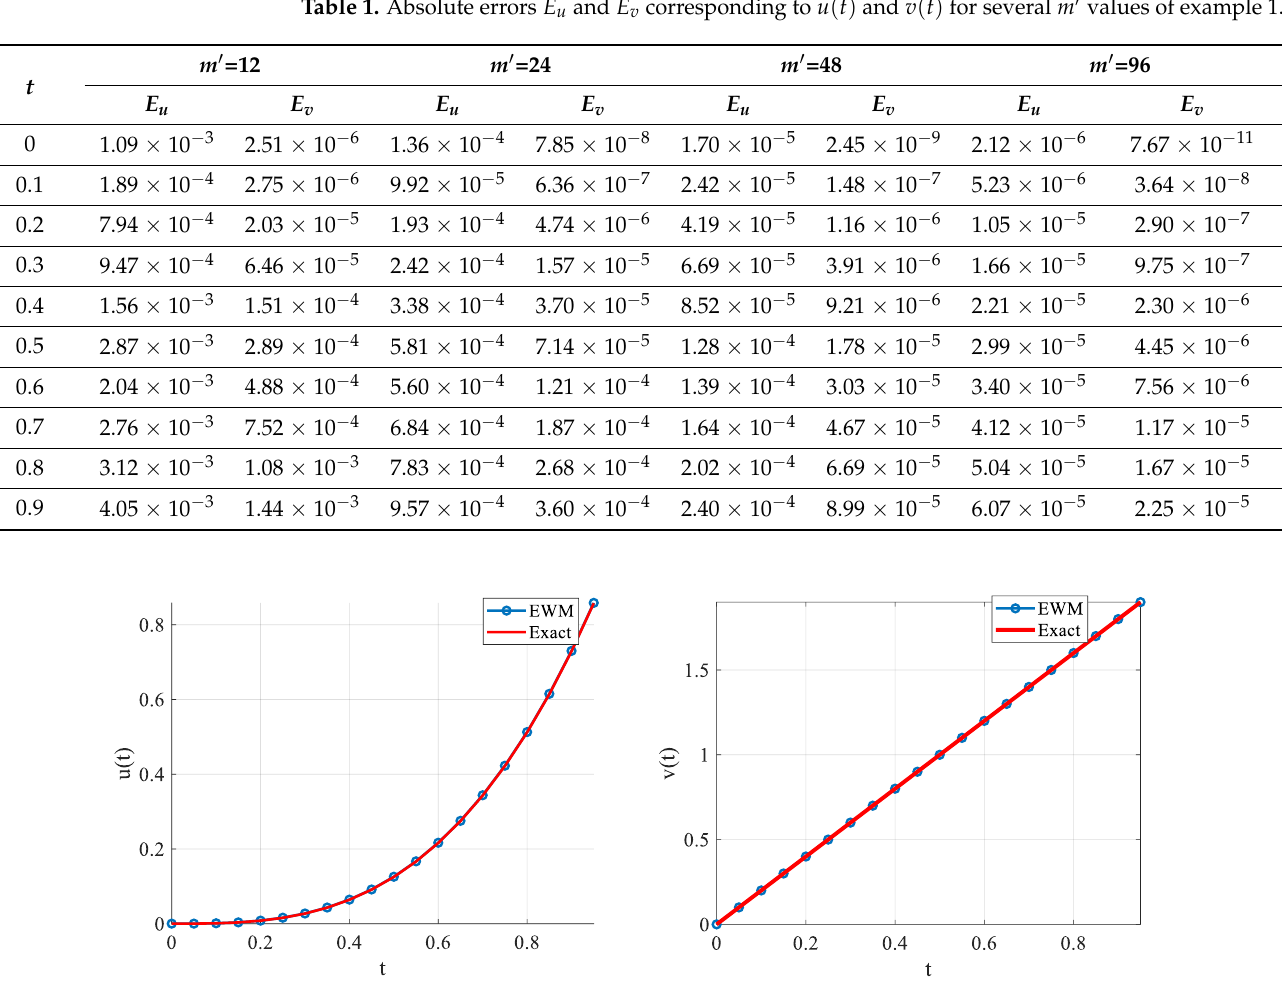
() v t () u t and for several m  values